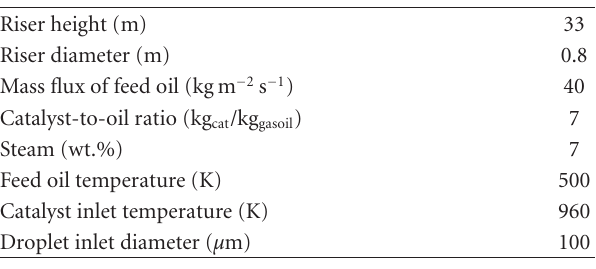
Table 6: Geometric details and operating conditions of the indus- trial riser.